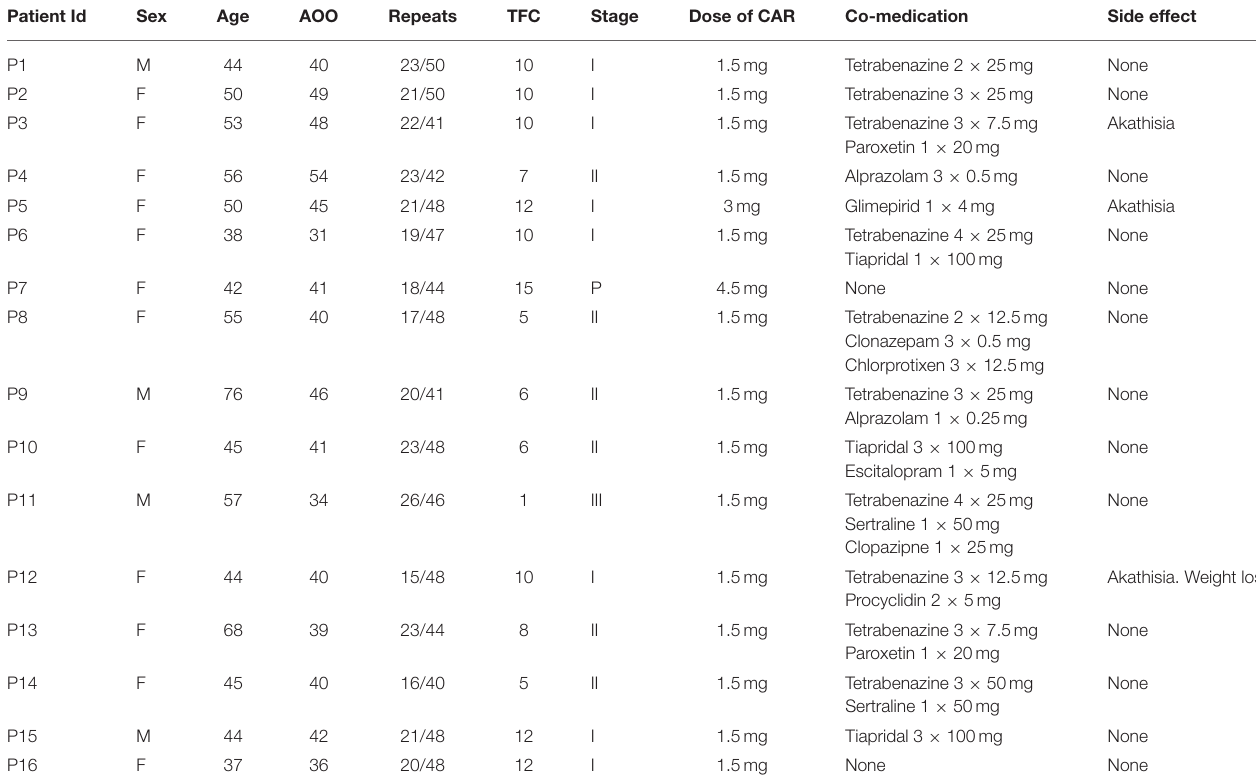
TABLE 1 | Demographic and clinical measures of participants. Patient